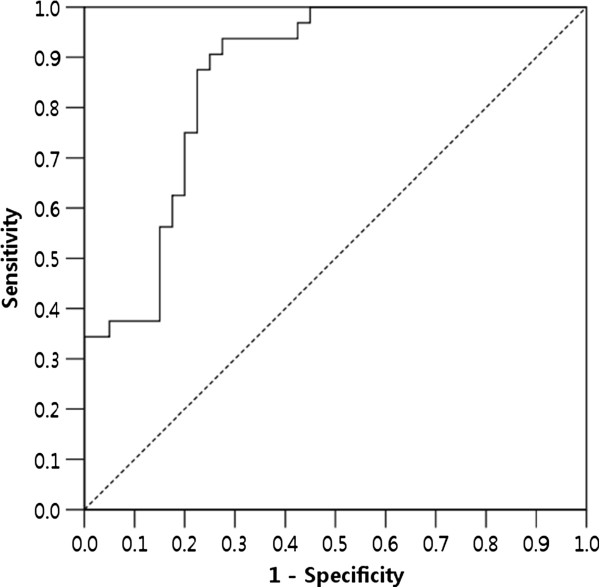
Receiver operating characteristic curve for V15Gy.